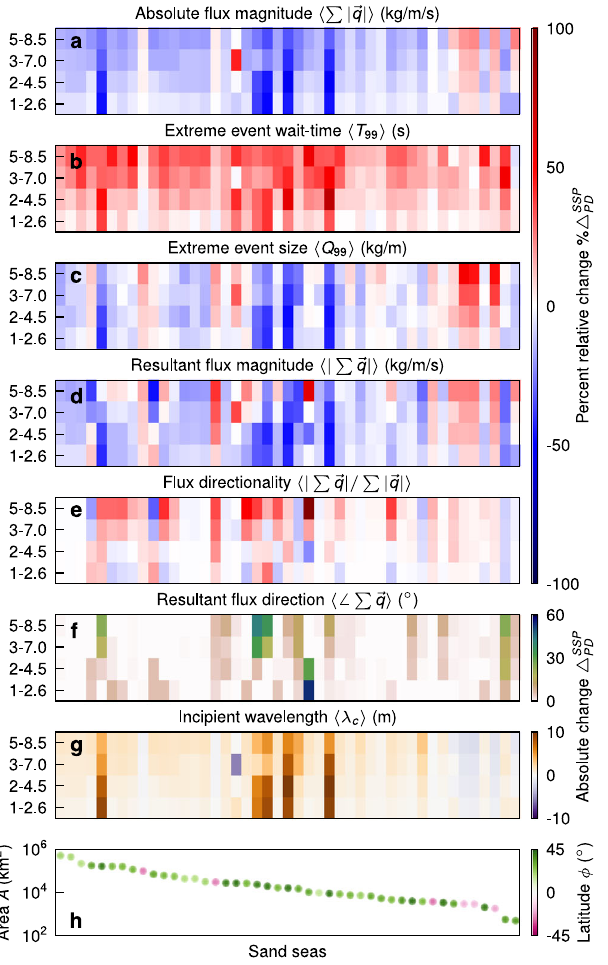
ffiffiffiffi p A (m), ! ( ∘ ) in